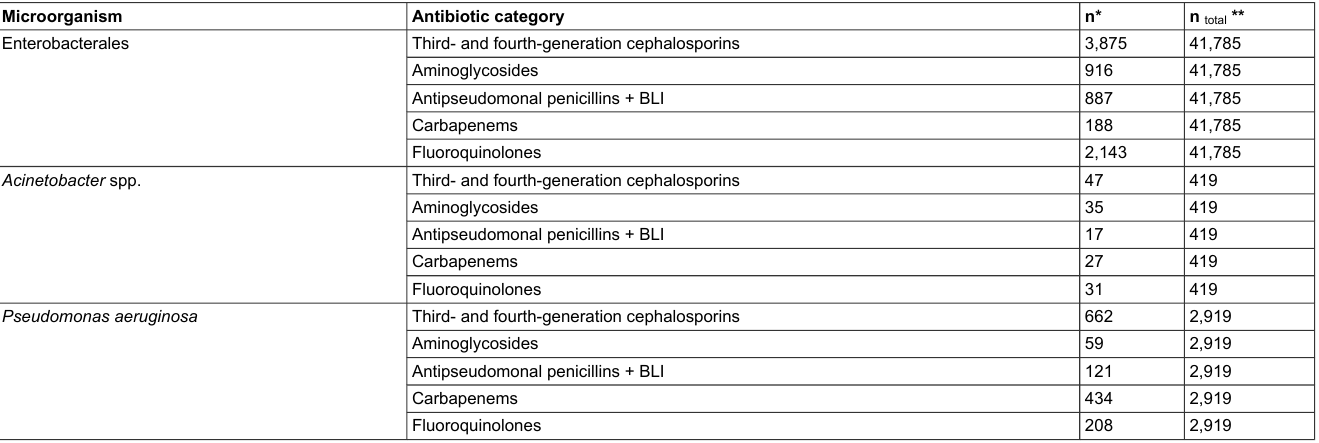
Table S3: Number of isolates considered for the cross-resistance